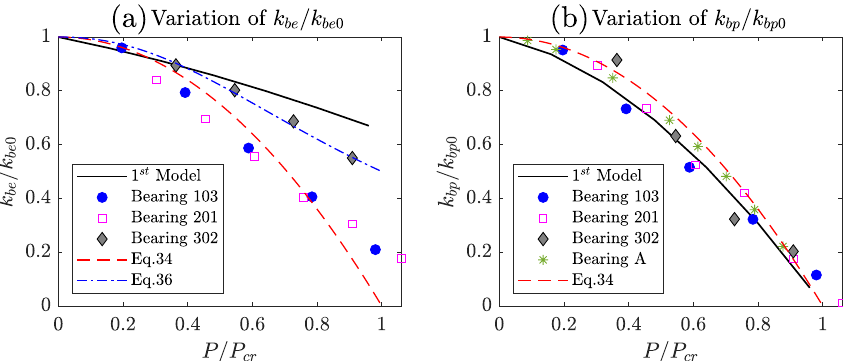
Fig. 8 Variation of normalized horizontal pre- and post-elastic stiffness with axial compression